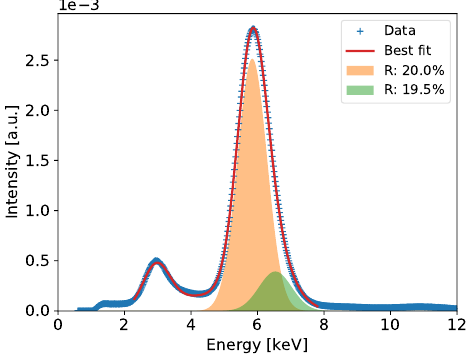
Figure 22. Standard GEM detector E with copper foils. 55 Fe spectrum for detector bias voltage of